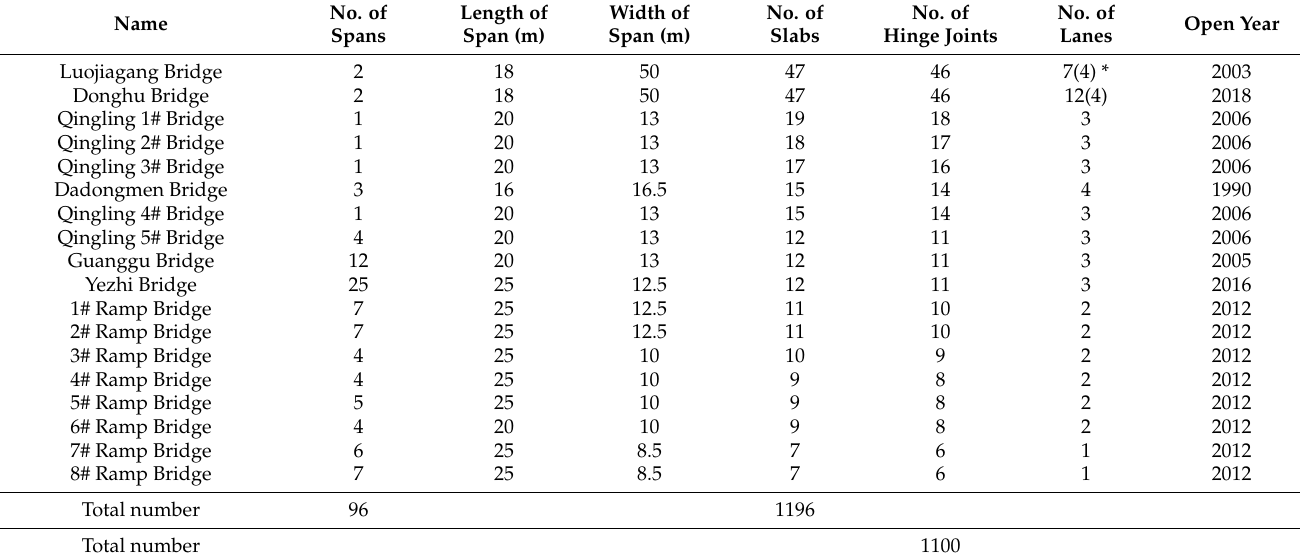
Table 1. The profiles of